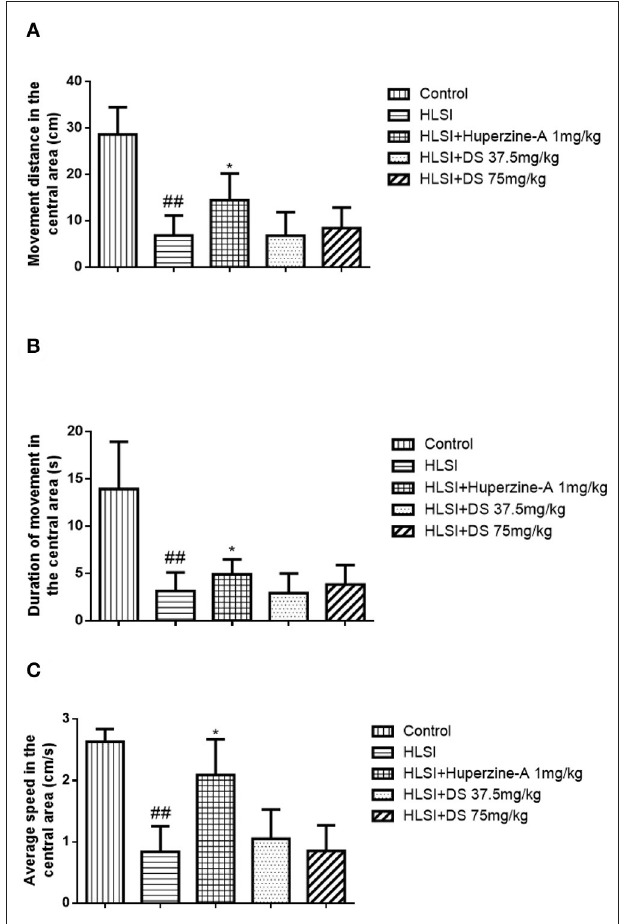
FIGURE 5 | The effects of DS on the locomotor activity in the open-field test after HLSI in rats. The values are mean ± SEM ( n = 8–9) for the following: (A) movement distance in the central area, (B) duration of movement in the central area, and (C) average speed in the central area. The symbols represent: ## p < 0.01 as compared with the control group; * p < 0.05 as compared with the HLSI